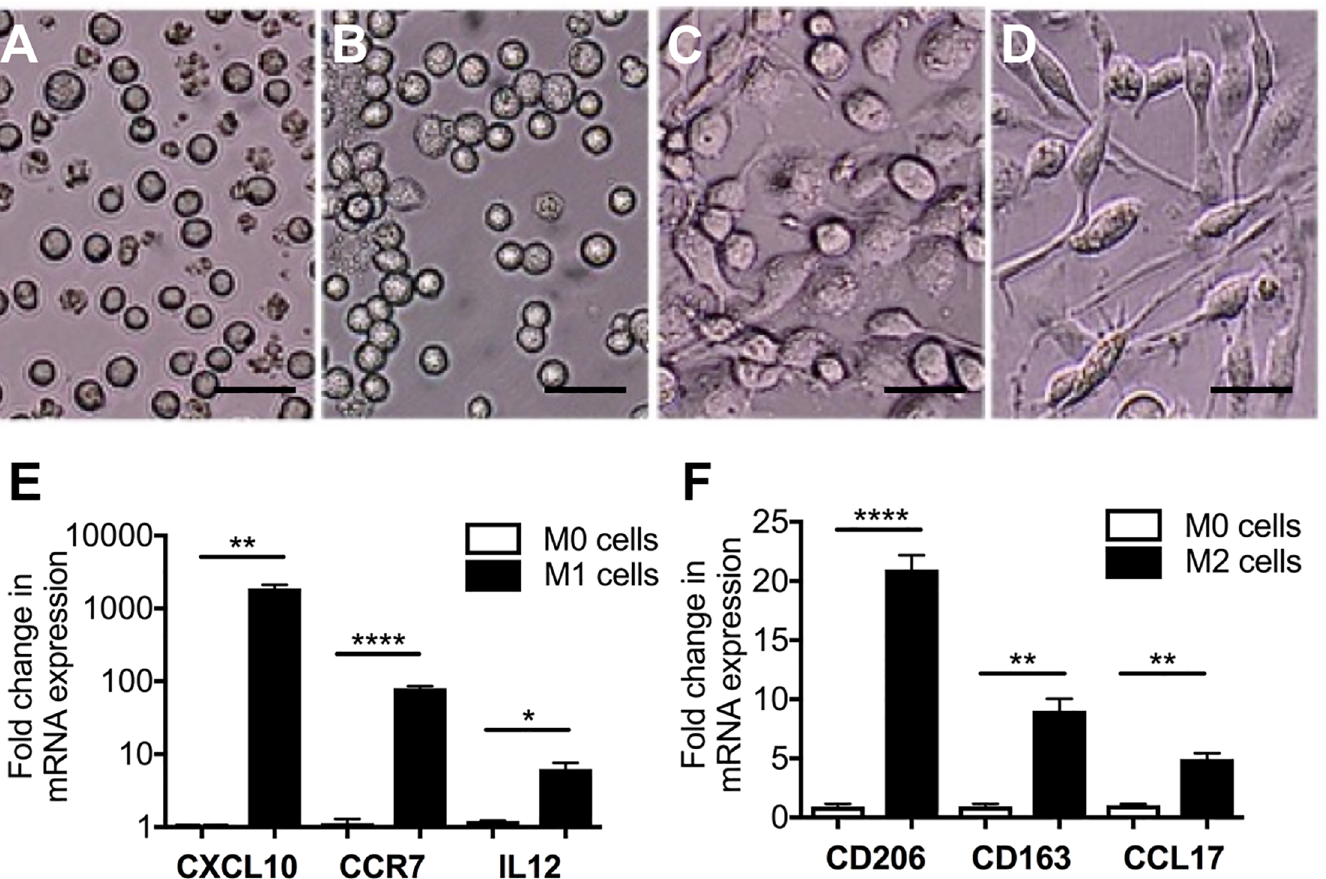
Fig 2. THP1 cells differentiated into polarized macrophages display characteristic morphology and markers of polarization. A-D, photomicrographs showing characteristic morphologies of THP1 cells (A), and differentiated M0 (B), M1 (C), and M2 (D) macrophages. M1 macrophages (C) appear flattened as compared with M0 cells (B), and M2 macrophages take on a more elongated shape (D). E-F, qPCR quantification of M1 (E) and M2 (F) macrophage markers in THP1-derived M1 and M2 cells, respectively, relative to M0 cells. The expression of M1 and M2 mRNA markers is consistent with the observed morphologies of the M1 (C) and M2 (D) macrophages. Graphs represent means ± standard error. Scale bar = 30 μm; (cid:3) = p < 0.05, (cid:3)(cid:3) = p < 0.01, and (cid:3)(cid:3)(cid:3)(cid:3) = p < 0.0001.